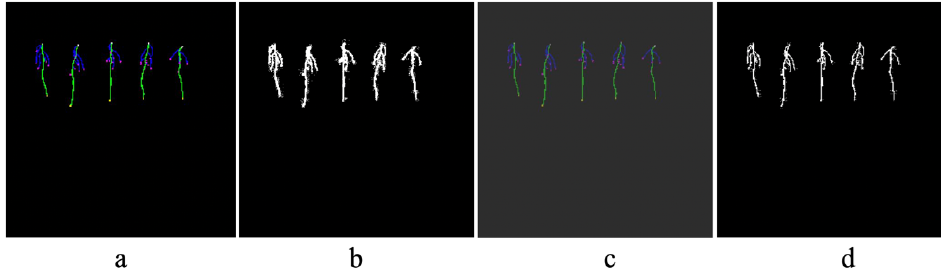
Figure 10. A comparison between a frame and its processed image. ( a ) Ground truth. ( b ) Processed ground truth. ( c ) Predicted frame. ( d ) Processed prediction frame.